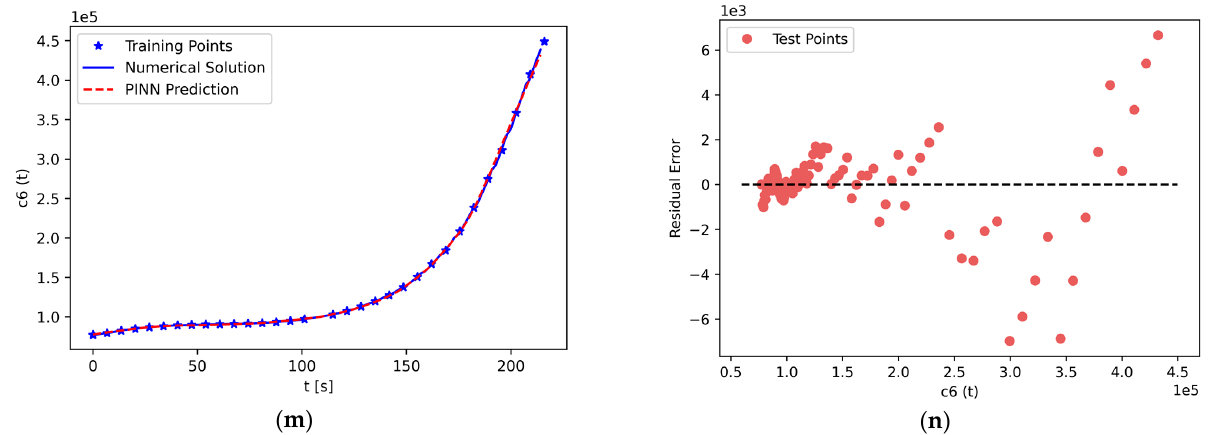
Figure 8. ( a ) Solution of neutron density concentration, n ( t ) , in the time interval t ∈ [ 0, 217 ] s , along with PINN prediction. ( b ) Residual error plot of n ( t ) , which shows the error margin of the predictions. ( c , e , g , i , k , m ) Solutions of delayed neutron precursor density concentration of c 1 ( t ) , c 2 ( t ) , c 3 ( t ) , c 4 ( t ) , c 5 ( t ) , and c 6 ( t ) , respectively, in the time interval t ∈ [ 0, 217 ] s , along with PINN prediction. ( d , f , h , j , l , n ) Residual error plot of c 1 ( t ) , c 2 ( t ) , c 3 ( t ) , c 4 ( t ) , c 5 ( t ) , and c 6 ( t ) , respectively.